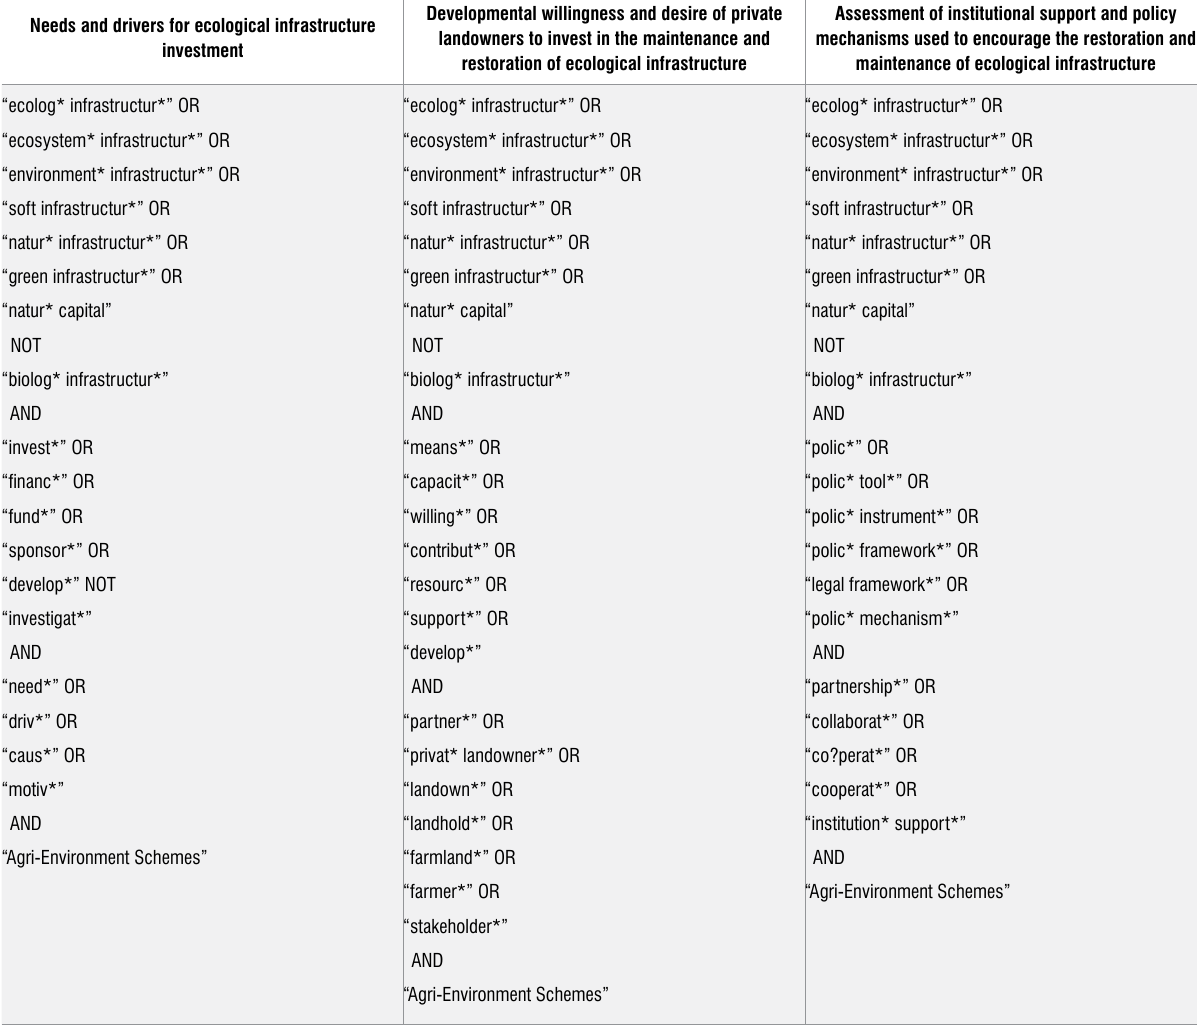
Combination of search strings used to compile literature based on three theme areas Developmental willingness and desire of private Needs and drivers for ecological infrastructure landowners to invest in the maintenance investment